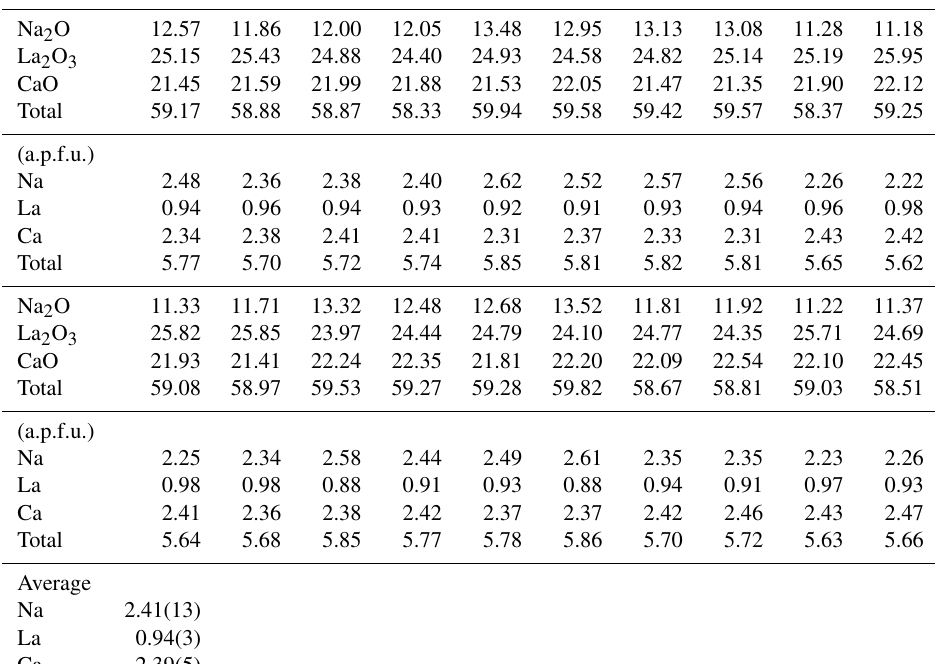
Table 1. Major element composition (in wt%) of the synthetic single crystals of burbankite in this study. The chemical formula has been calculated on five oxygens.